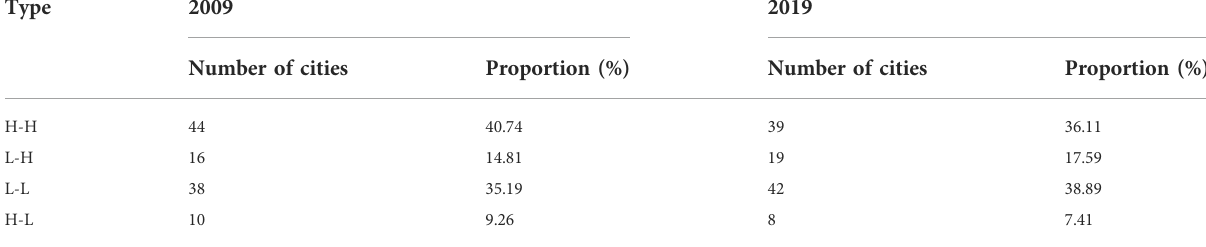
TABLE 3 Spatial correlation type statistics of coupling degree between the USFD and green economic